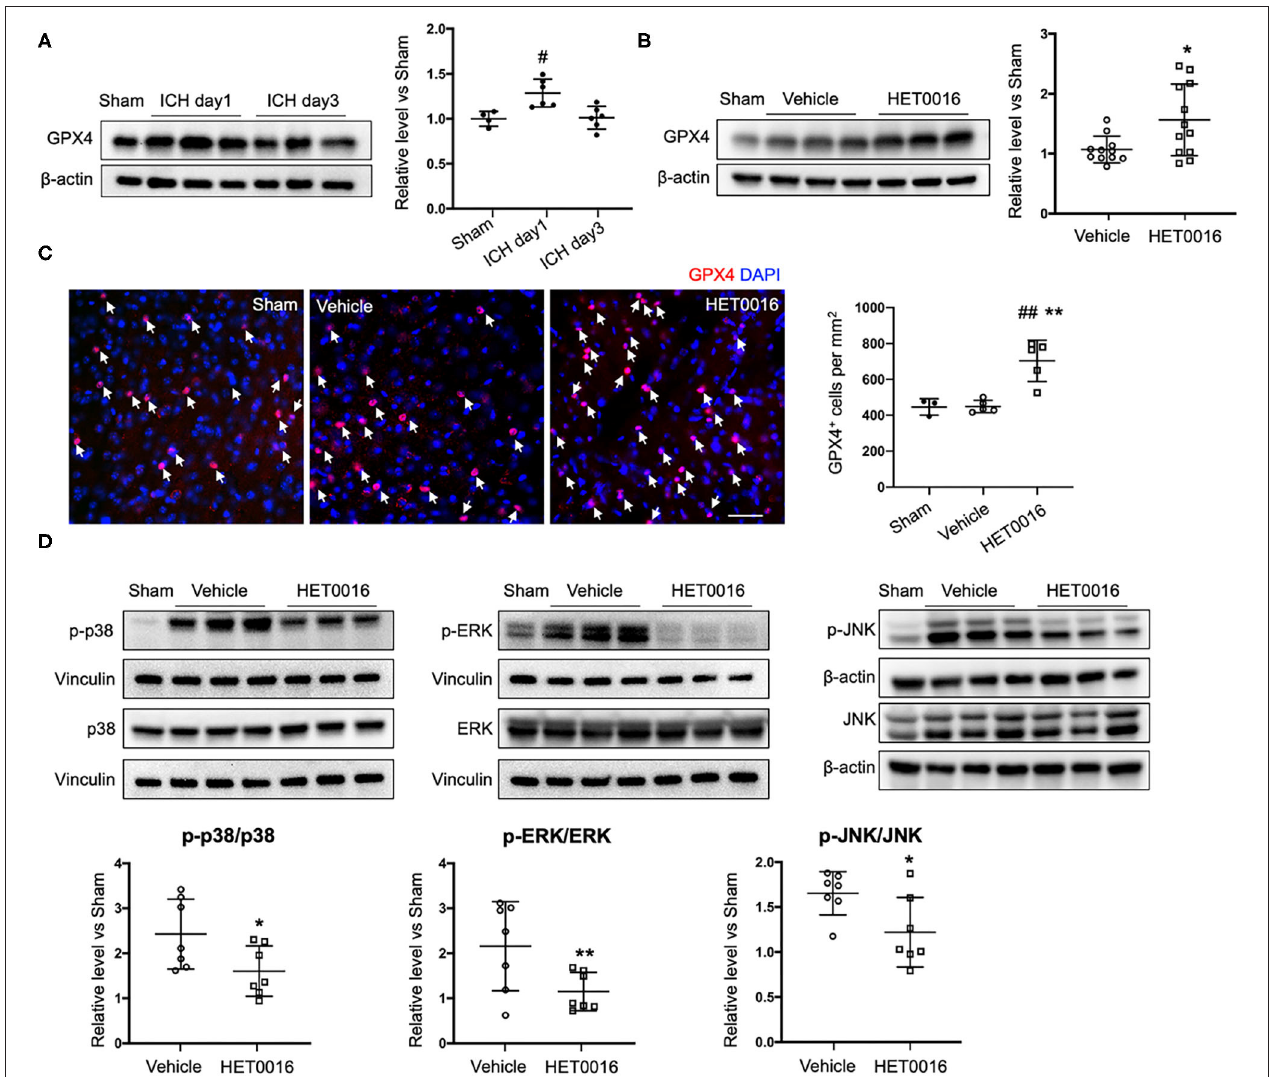
FIGURE 6 | HET0016 affects ferroptosis pathway after ICH in mice. (A) Brain tissue surrounding the hematoma was harvested 1 and 3 days after ICH, and total protein was extracted for western blotting. Glutathione peroxidase (GPX) 4 expression was significantly higher at day 1 post-ICH than it was in the sham group and then declined to baseline at day 3 post-ICH. n = 4 in sham group, n = 6 in ICH groups. (B) Western blot analysis shows GPX4 expression in brain tissues from different groups at day 3 after ICH. GPX4 level was significantly higher in the HET0016-treated group than in the vehicle-treated group. n = 12/group. (C) Immunofluorescence staining was carried out 3 days after ICH for GPX4 (red) and nuclei (blue). Arrows indicate the GPX4–positive cells. Scale bar is 30 µ m. Quantification of GPX4 positive cell density is shown. (D) Total and phospho-P38/ERK1/2/JNK expression 3 days after ICH. Values were calculated as ratios of phospho- to total-p38/ERK1/2/JNK and further normalized to vinculin or β -actin loading controls. The ratios of p-p38/p38, p-ERK1/2/ERK1/2, and p-JNK/JNK were significantly lower in the HET0016-treated group than in the vehicle-treated group. n = 7/group. # P < 0.05, ## P < 0.01 vs. Sham group; * P < 0.05, ** P < 0.01 vs. Vehicle group. One-way ANOVA followed by appropriate post-hoc test was applied for multiple comparison and t -test for two group comparison. Data are expressed as mean ±